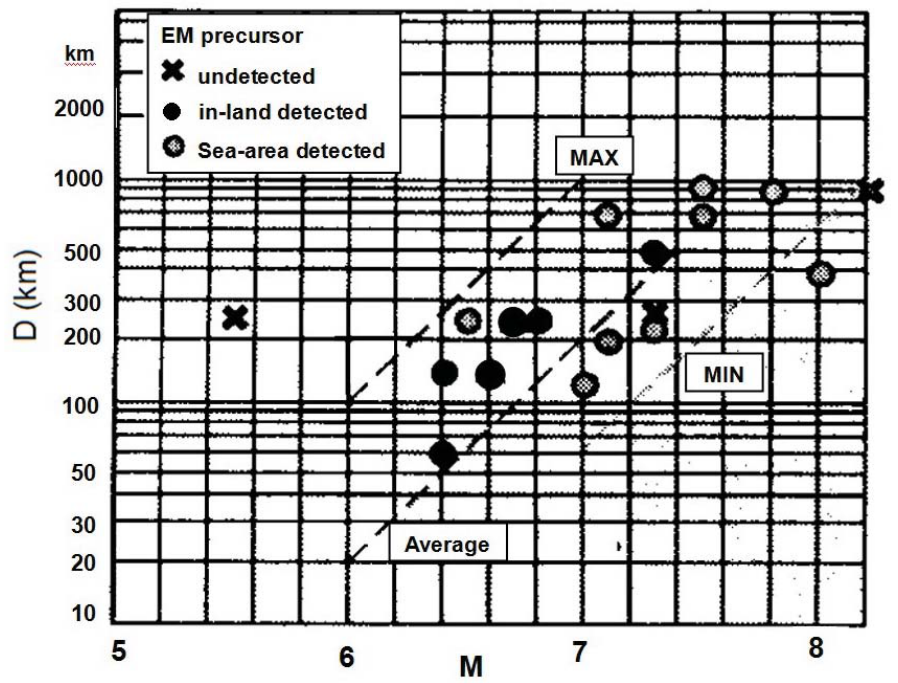
Figure 6. ELF radio noise plotted as M-D relation. Adapted from Hata et al. (2006) [32] with permission of the